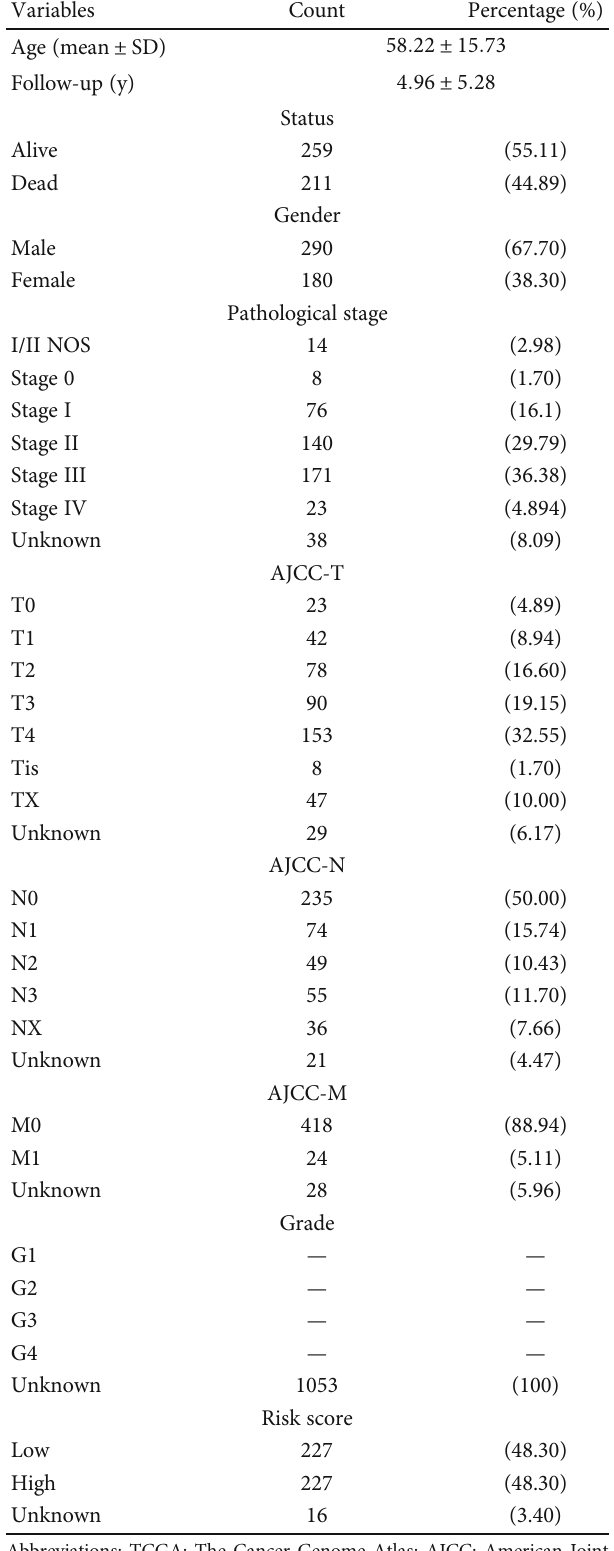
Table 1: Baseline characteristics of 470 melanoma patients included in this